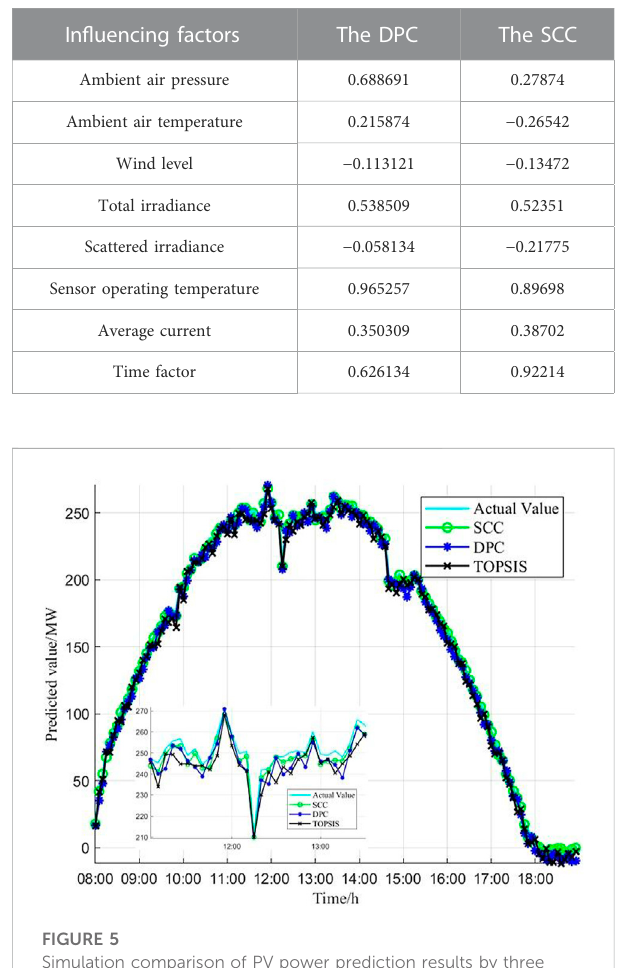
TABLE 3 The results of the through-hole analysis.